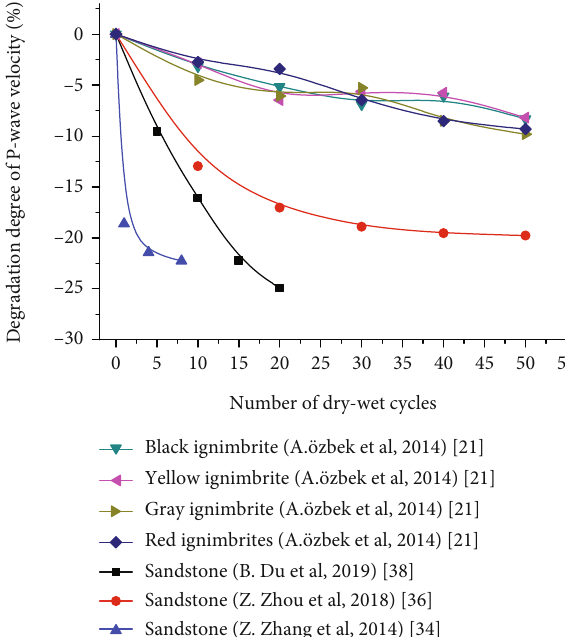
Figure 7: Degradation degree of P-wave velocity after di ff erent dry- wet